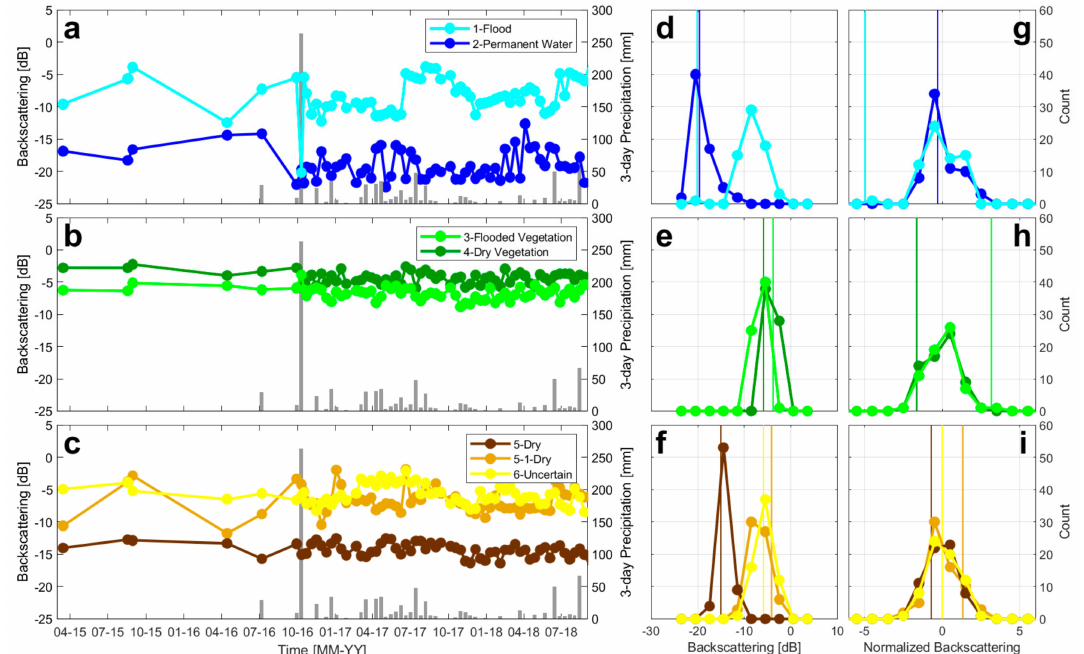
Figure 4. ( a – c ) σ 0 time series of selected pixels for the 6 classes in the validation dataset. The location of each sample pixel is marked in Figure 2, with the same ID number as shown in the legend (e.g., “1-Flood” in the legend of Figure 4a is from the sample pixel 1 in Figure 2). The grey bars in the background are 3-day cumulative precipitation from Global Precipitation Measurement daily solutions [26]. The during-event epoch is marked by the precipitation record of > 250 mm. ( d – f ) Histogram of the time series. The vertical lines stand for the σ 0 values on the during-event epoch. ( g – i ) Histogram of normalized time series. Vertical lines stand for the during-event σ 0 values after